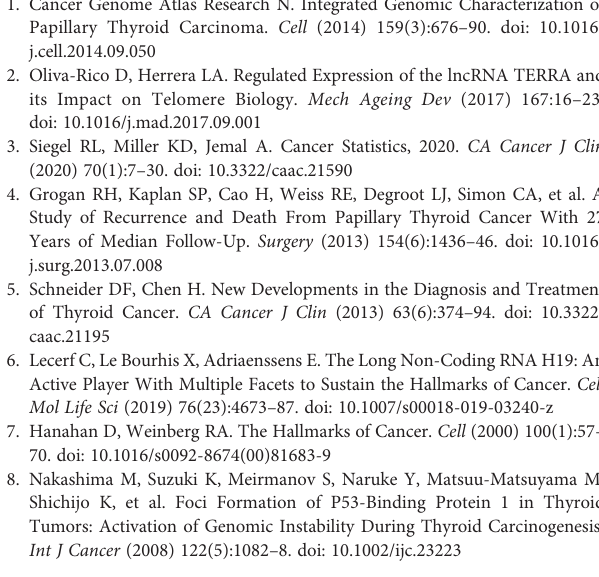
Supplementary Figure 1 | Patient strati fi cation based on key clinical- pathological parameters. Kaplan – Meier estimates of PFS in high- and low-risk groups of patients with different (A – B) age, (C – D) gender, (E – F) tumor size, (G – H) lymph nodes involvement, (I – J) clinical stage, and (K – L) radiation therapy status. Statistical analysis was performed using the log-rank test and univariate Cox analysis. PFS, progression-free survival. Supplementary Figure 2 | The expression pattern of FOXD2-AS1 , LINC01614 , AC073257.2 and AC005082.1 of pan-cancers in TCGA combined with